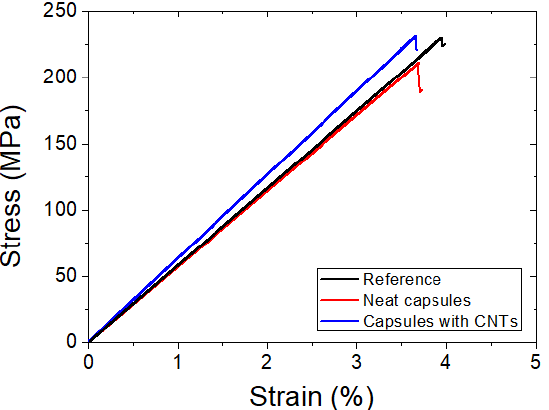
Figure 10. Representative plots of reference (black line), neat system (red line) and nanomodified system (blue line) of lap strap specimens.